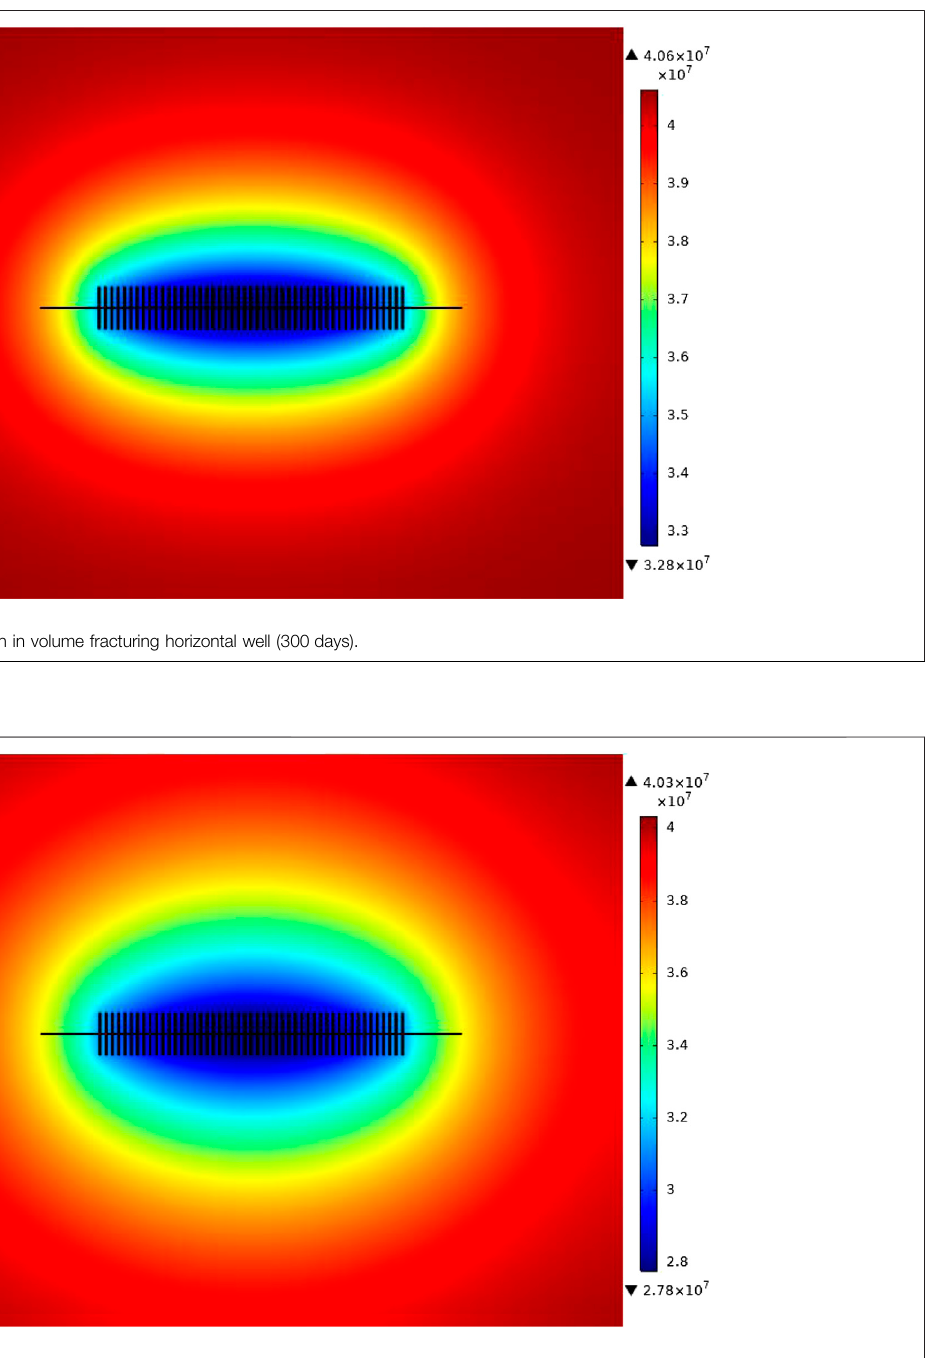
FIGURE 6 | Formation pressure distribution in volume fracturing horizontal well (600